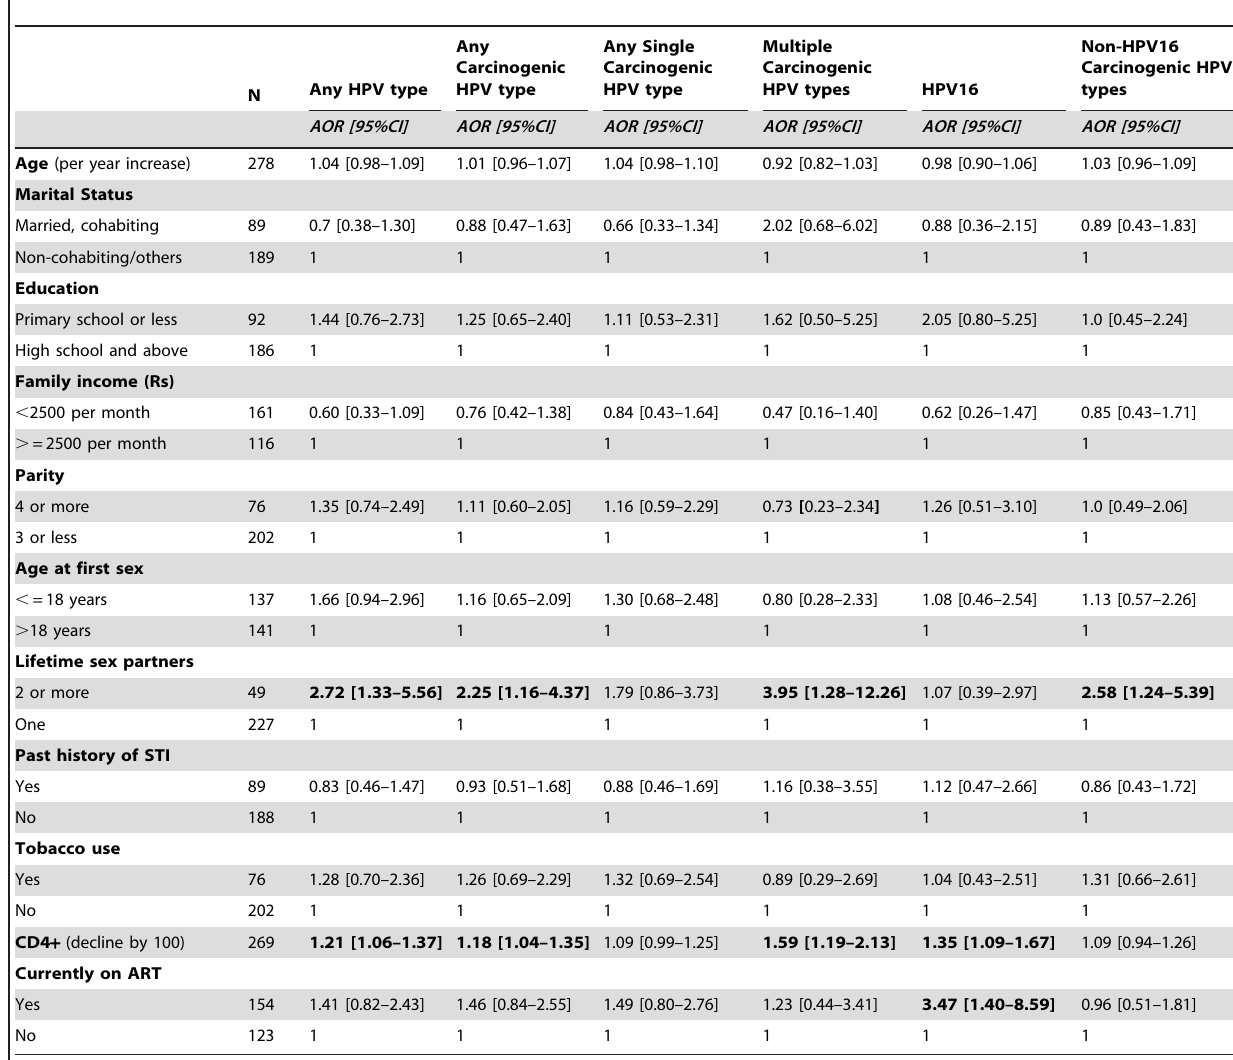
Footnotes to Table 2: Abbreviations: HPV: human papillomavirus, STI: sexually transmitted infection, ART: antiretroviral therapy, AOR: adjusted odds ratio, 95%CI: Lower limits and upper limits of the 95% Confidence intervals. All Odds ratios presented in this table are adjusted (through multivariable logistic regression) for the covariates presented.